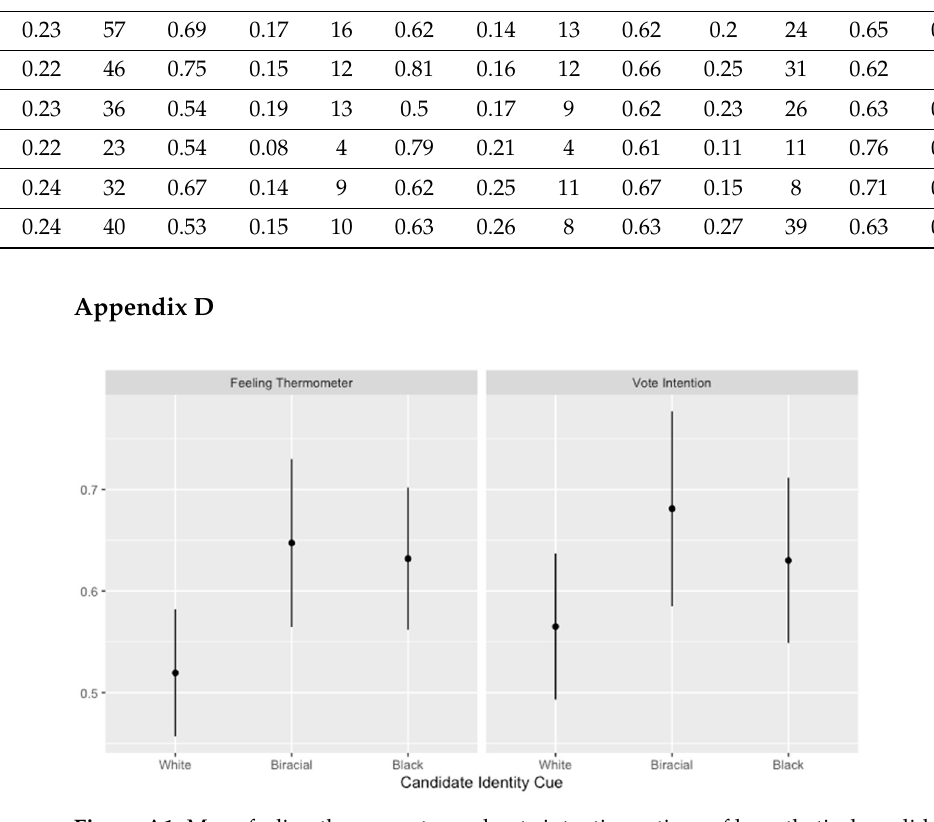
Figure A1. Mean feeling thermometer and vote intention ratings of hypothetical candidates from the Black and White heritage treatment conditions. Sample includes only mixed-race participants who indicated two or more racial heritages among their parents. X -axis denotes different treatment groups based on the identity cued by our hypothetical candidates. Note: error bars denote 95% confidence intervals. Table A4. Results from difference-of-means t -tests for all possible treatment group comparisons in Figure A1. Difference of